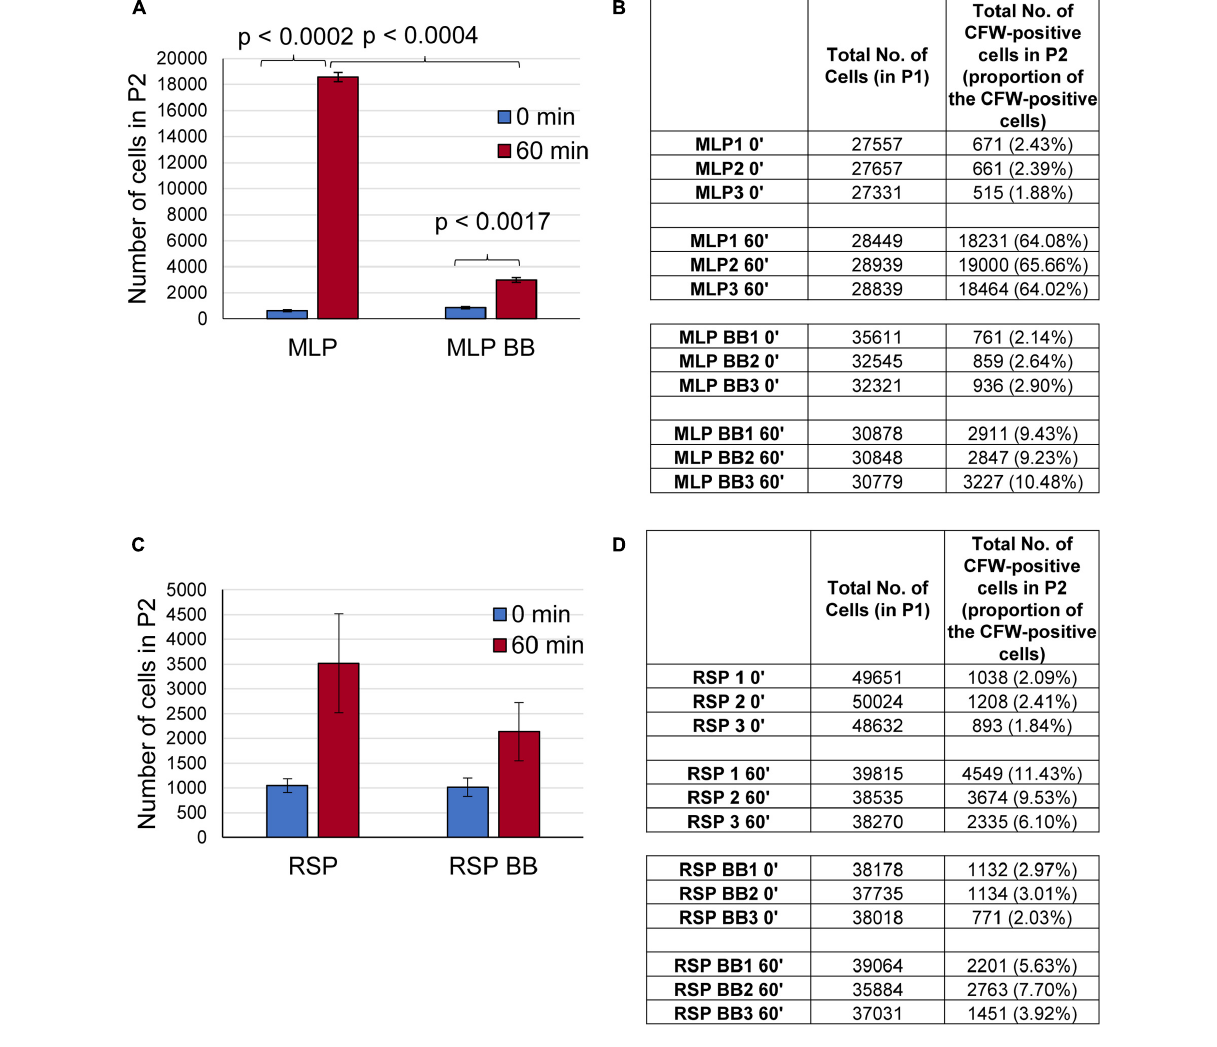
FIGURE 5 | Presence of polysaccharide on the surface of the cells of the rifampicin surviving population (RSP). (A–D) Quantitation of the flow cytometric analysis of calcofluor white (CFW) stained Mtb MLP and RSP cells before and after bead beating. Bar graph and table showing the number of cells of the: (A,B) MLP and (C,D) RSP in the P2 gate after 60 min of CFW staining. The proportions of the respective cells are indicated in parenthesis. Statistical significance was calculated using paired t- test ( n =